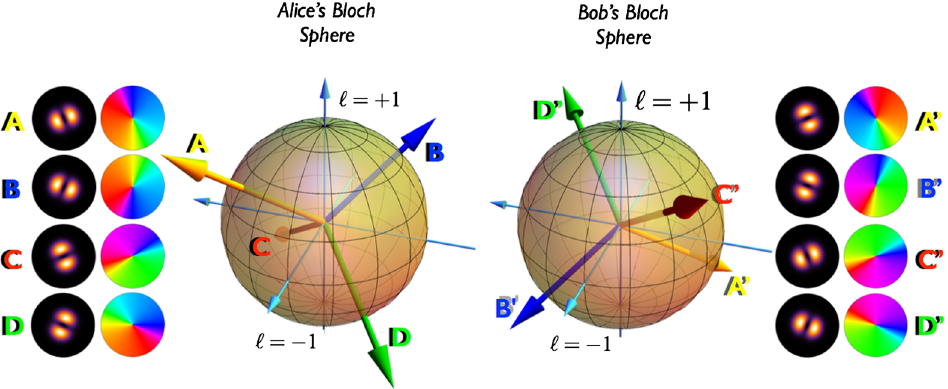
FIG. 5. State representation of SIC POVMs for OAM qubit on Alice ’ s and Bob ’ s Bloch (Poincaré) spheres. The two sets of vectors f A; B; C; D g and f A 0 ; B 0 ; C 0 ; D 0 g represent Alice ’ s and Bob ’ s SIC POVM elements, respectively. Any pair of conjugate vectors, e.g., A and A 0 , are orthogonal, and hence a qubit generated by Alice in one of these states has zero probability of being detected as the conjugate state, and equal probabilities of the remaining three. We intently draw the vectors to be outside of the Bloch spheres. Indeed, the implemented states are on the surface of the Bloch spheres, since they are pure